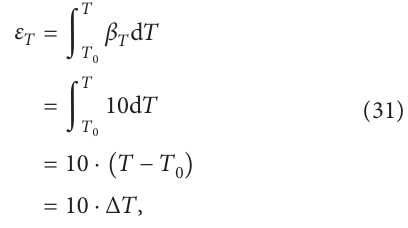
Figure 7: Schematic diagram of capillary water tension of concrete